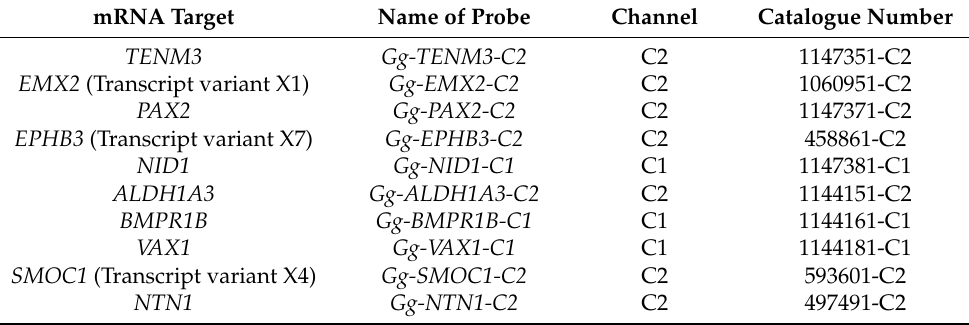
Table 1. RNAscope Custom-designed and Catalogue Probes